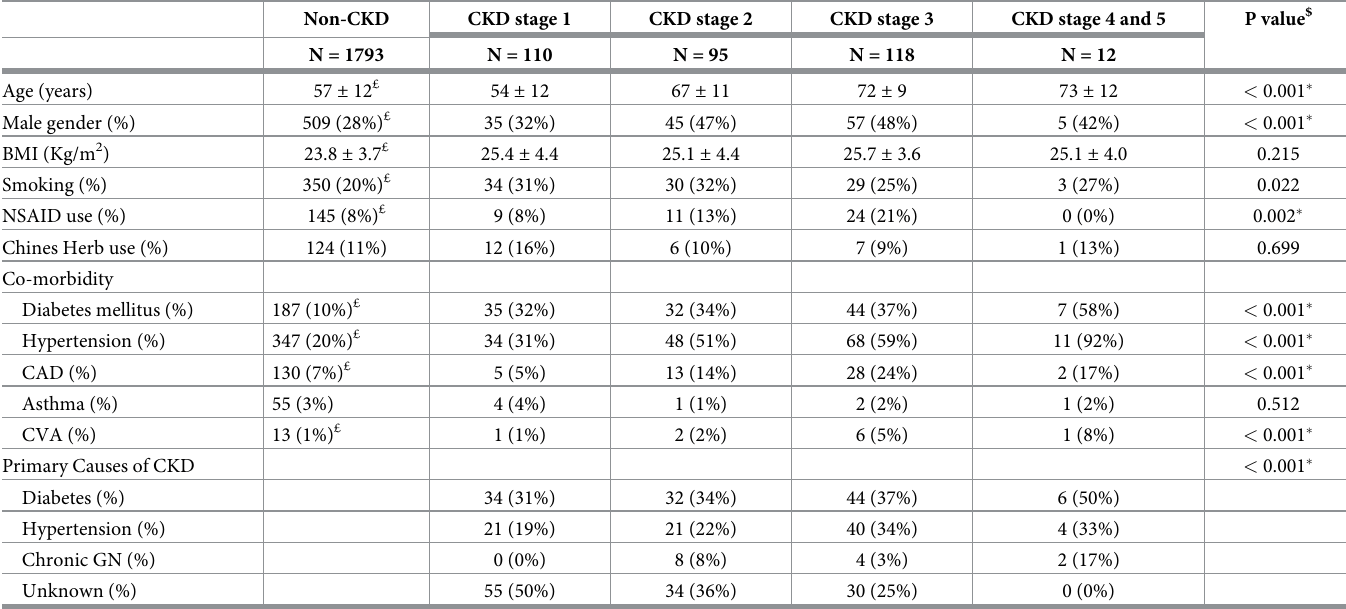
Table 1. Demographic data of non-CKD and CKD patients with different CKD